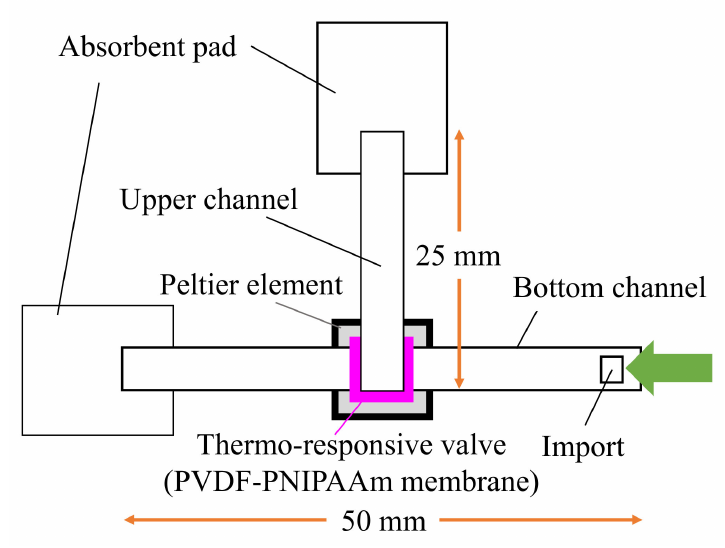
Figure 4. Schematic of the evaluation system used to assess valve performance. The polymerized membrane was stacked in a T-shape between two nitrocellulose membranes, and colored water flowed through the import. If the valve was closed, the water flowed only in the horizontal direction; if the valve was open, it flowed in the upper channel. The temperature of the valve was controlled by adjusting the current flowing through the Peltier